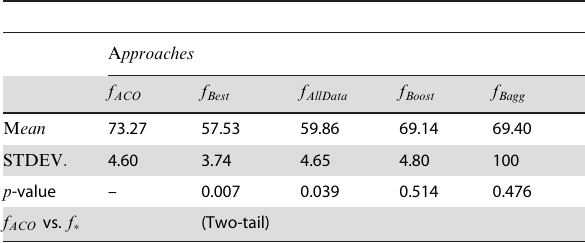
Table 8. Experimental results for HD prediction problem. Accuracy percentage values of ACO and